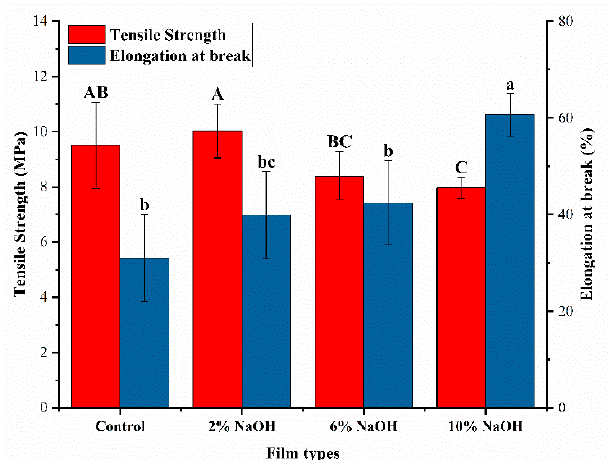
Figure 2. Tensile strength and elongation at break of HAS films treated with different concentrations NaOH. Di ff erent letters in the same column represent significant di ff erences, p < of NaOH. Different letters in the same column represent significant differences, p < 0.05.